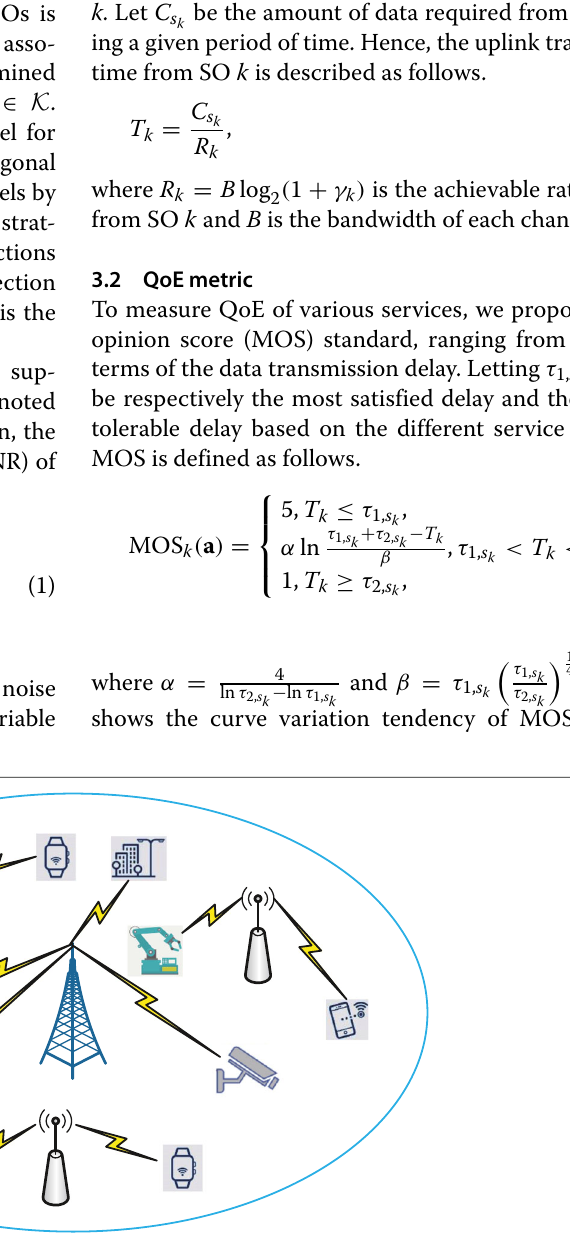
Fig. 1 The 5G-enabled IoT